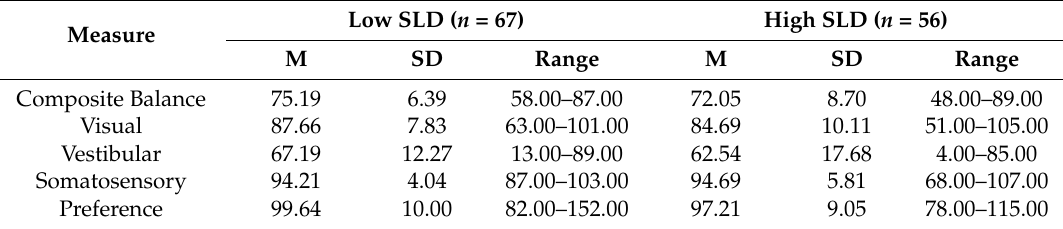
Table 2. Neurocom data descriptives compared with low and high sleep disturbance.